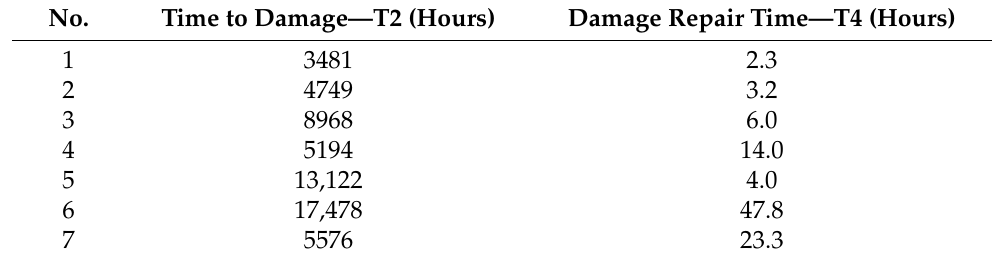
Table 4. Empirical data for the coal mill falling pipe used in statistical analysis of damages and time needed for their